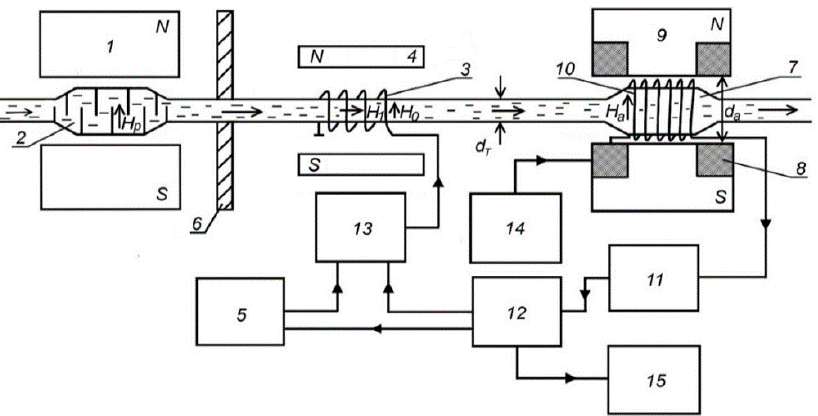
Figure 3. Structural diagram of the laboratory model of NMR label flowmeter and relax о meter: 1 — polarizer magnet; 2 — polarizer vessel; 3 — nutation coil; 4 — magnet of the constant field; 5 — genera- tors of nutation and modulation coils; 6 — magnetic shield; 7 — analyzer vessel; 8 — coils for modulat- ing the field of the analyzer magnet; 9 — analyzer magnet; 10 — coil for recording NMR signal; 11 — circuit for recording an NMR signal; 12 — processing and control diagram; 13 — electronic keys; 14 — radio frequency generator; and 15 — indication circuit.